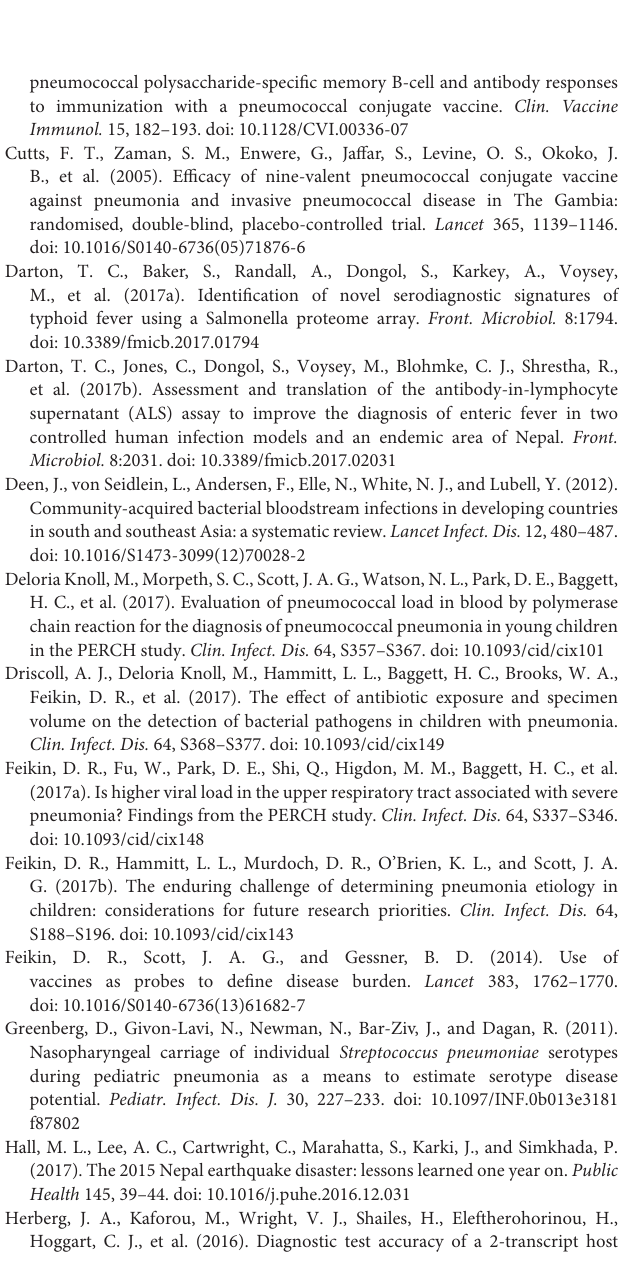
introduction of the vaccine into the Kathmandu valley. Error bars show 95% confidence intervals. Figure S2 | Acute IgG ALS to pneumococcal proteins by children with pneumococcal pneumonia and healthy infant controls. Dashed horizontal lines represent represent thresholds derived from the Youden Index, p -values were derived from the Wilcoxon rank sum test. For all box and whisker plots: the solid line represents the median value, lower hinge 25th centile, upper hinge 75th centile, and whiskers represent 1.5 times the interquartile range. All data points have also been plotted. Figure S3 | Linear regression analysis of length of illness with acute IgG ALS to pneumococcal proteins (grey colouring represents 95% confidence intervals about the regression line; p -value > 0.5 for all proteins). Figure S4 | Acute IgG ALS to pneumococcal proteins in children with non-pneumococcal pneumonia by nasopharyngeal carriage of